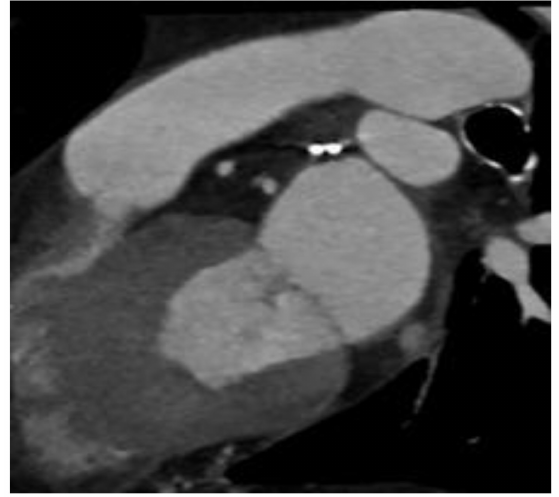
Figure 1. Clip short axis.